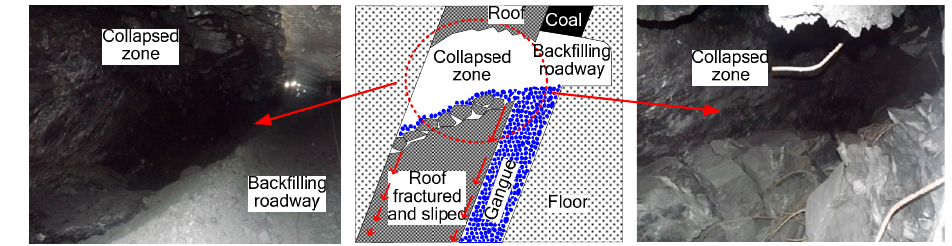
Figure 4. Roof fracture at the upper gate roadway.